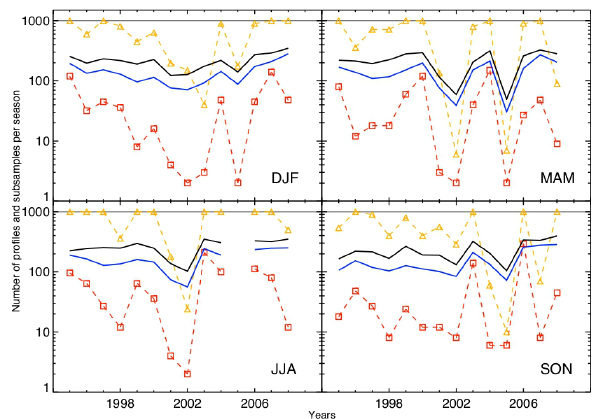
Fig. 2. Time record of the number of vertical profiles taken per sea- son over Frankfurt between 1995 and 2008, in the whole data set (black) and in the morning (blue) subset in solid lines. The number of seasonal subsamples created with a frequency of 4 (orange) and 12 (red) profiles a month using the “regular” sampling method is shown by the dashed